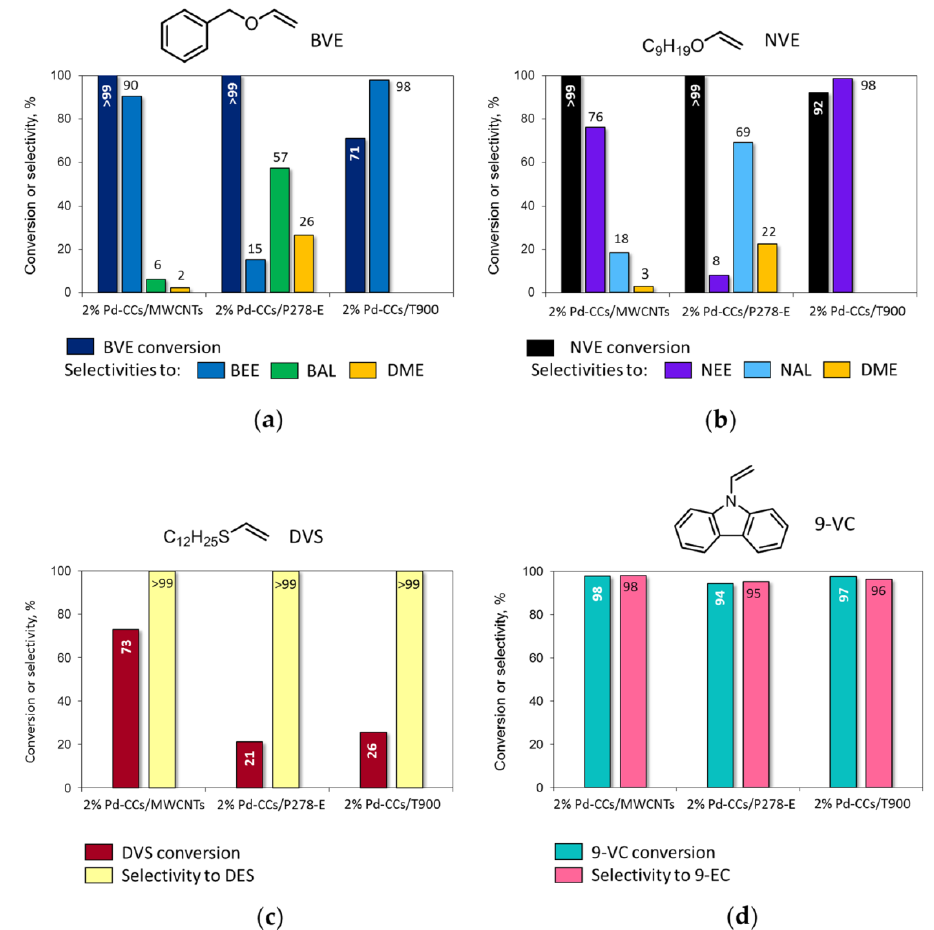
Figure 2. Catalytic performance of 2% Pd-CCs/C catalysts based on different carbon supports in the liquid-phase hydrogenation of vinyl derivatives: ( a ) benzyl vinyl ether (BVE); ( b ) nonyl vinyl ether (NVE); ( c ) dodecyl vinyl sulfide (DVS); ( d ) 9-vinylcarbazole (9-VC). Reaction conditions: 20 mg catalyst (50 mg 2% Pd-CCs/T900 for hydrogenation of 9-VC), 50 mg substrate, 2.0 mL MeOH (benzene for hydrogenation of 9-VC), 295 K, 1.0 MPa H 2 , 2 h. The products were identified by NMR and GC–MS (see Supplementary Materials).